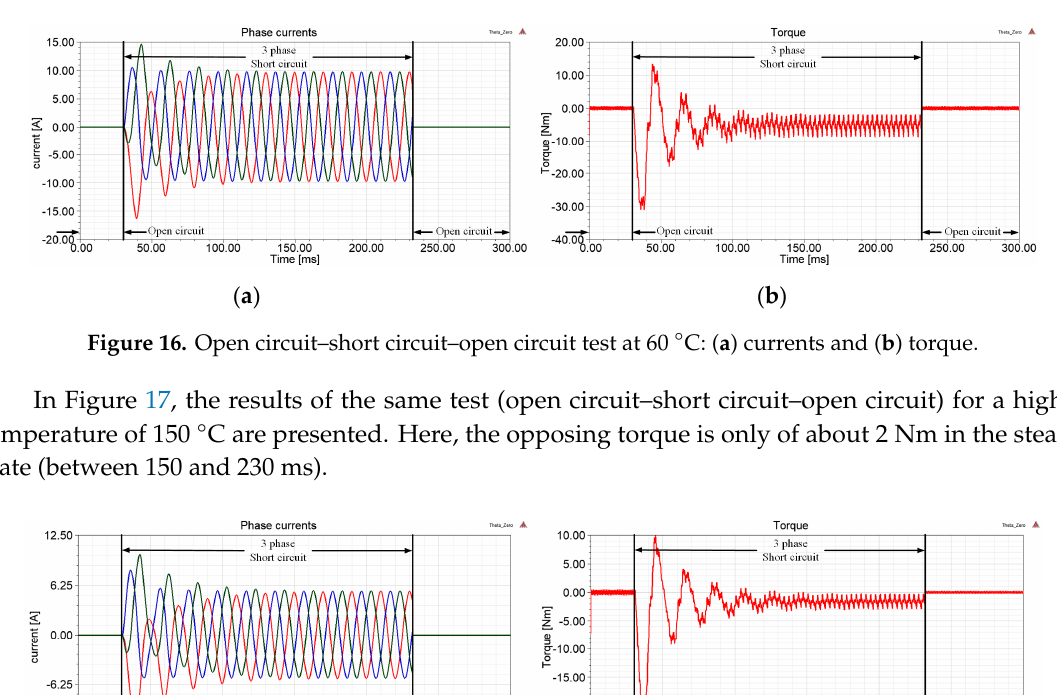
Figure 15. Back EMF before, during, and after the three-phase short circuit for ( a ) 60 °C and ( b ) 150 °C.